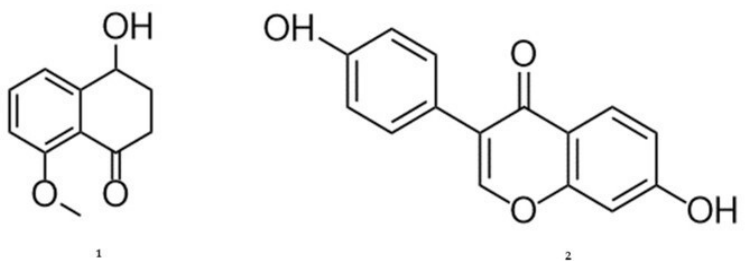
Figure 2. Structures of nodulisporone sodium ( 1 ) and daidzein ( 2 ) detected by LC-MS/MS in the EtOAc extract of the fungus A. stygium WL1B5. Chemical structures were drawn using the